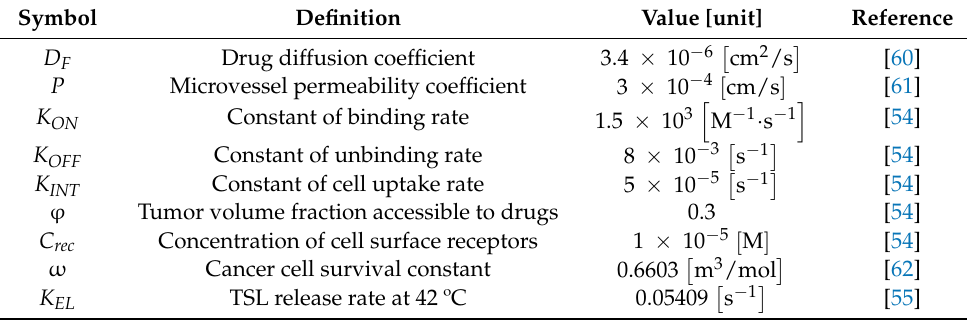
Table 3. Parameters for solute transport employed in drug delivery